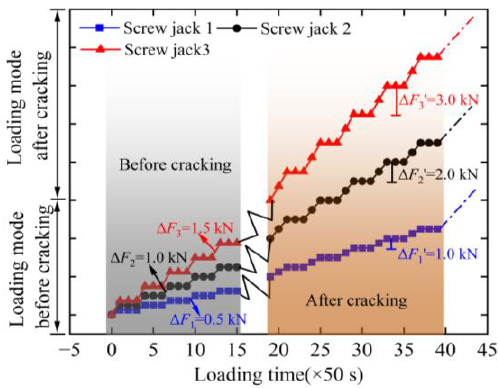
Figure 8. Loading design of the test